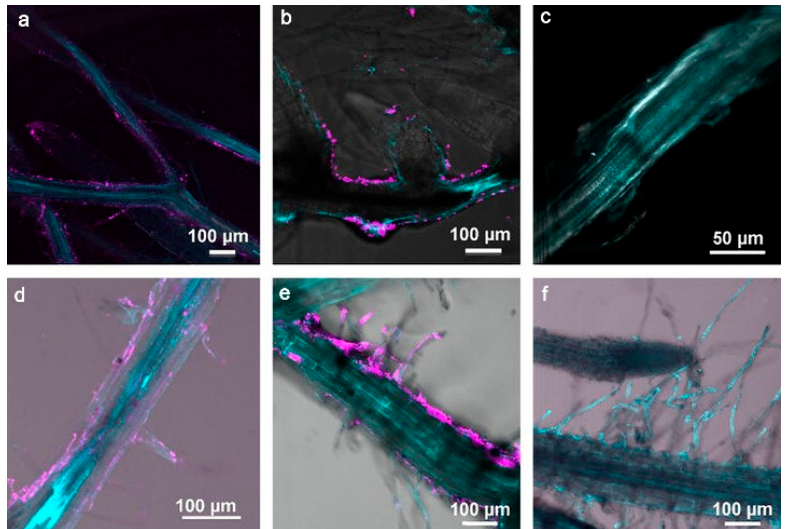
Figure 5. Superposition of fluorescence and light microscopy images of plants’ roots from exposure to QD suspensions in Hoagland’s solution (HS) for ( a ) 1 day and ( b ) 7 days, and HS + humic acids (HAs) for ( d ) 1 day and ( e ) 7 days. Images of unexposed plants in ( c ) HS and ( f ) HS + HA are also provided for comparison. QD emission is shown in pink. Endogenous emission is shown in blue-green. Reprinted with permission from Ref. [49].